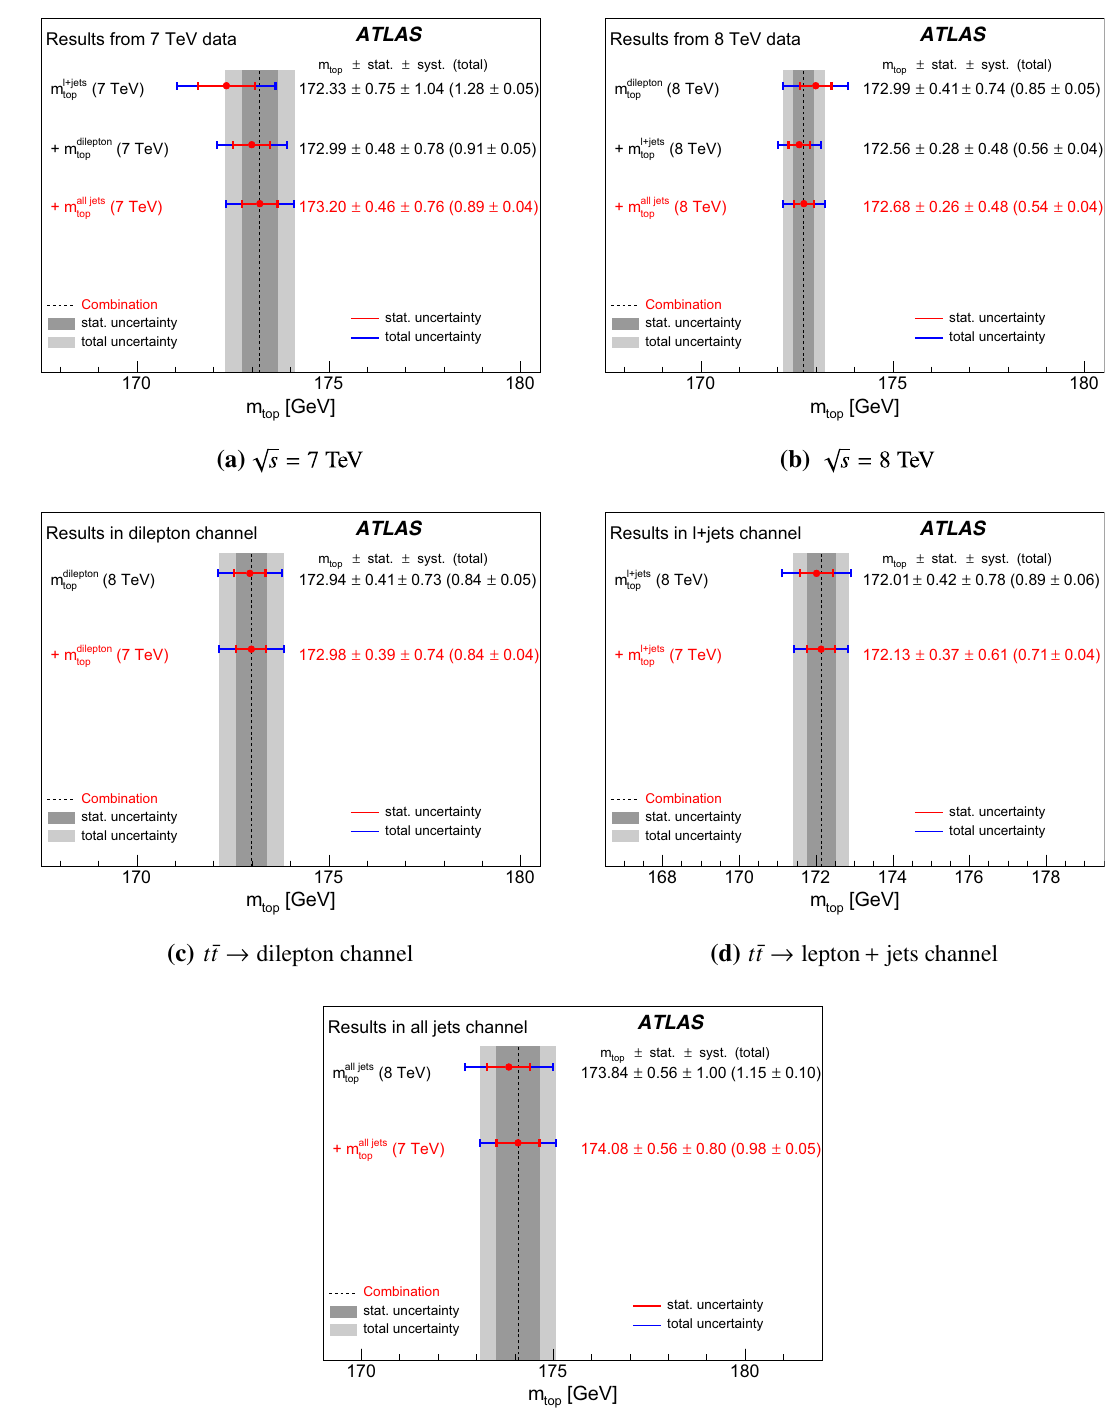
Fig. 13 Selected combinations of the six ATLAS measurements of m top according to importance. The figures show the combined result when successively adding results to the most precise one of a given cat- egory. Each line of this figure shows the combined result when adding theresultlistedtothecombination,indicatedbya‘+’.Thevaluesquoted are the combined value, the statistical uncertainty, the systematic uncer-